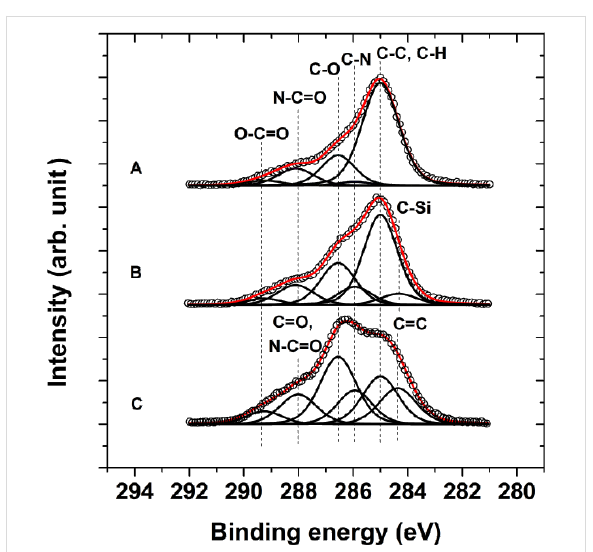
Figure 6: High resolution C 1s XPS spectra of alginate coatings on neridronate (A), APTES siloxane (B) and PDA (C) anchoring layers. The unfilled circles represent the measured data, while the red lines represent the fitted data. The individual contributions to the fitted data of different functional groups present in the films are represented with black